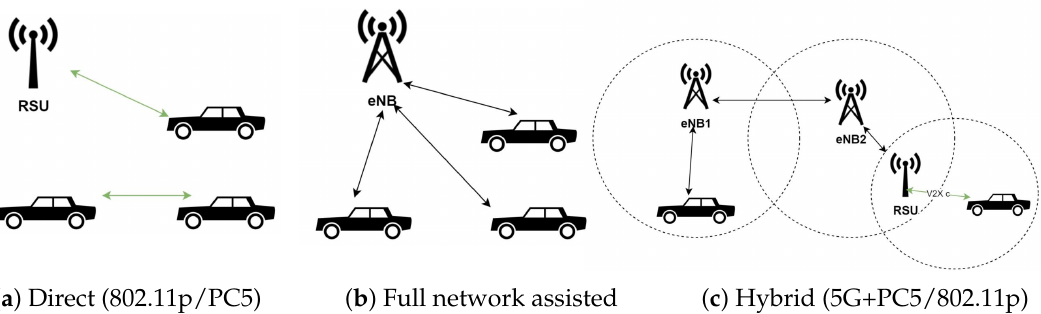
Figure 2. Different types of Vehicle-to-Vehicle (V2V) and Vehicle-to-Infrastructure (V2I) scenarios. ( a ) Direct (802.11p/PC5) ( b ) Full network assisted and ( c ) Hybrid